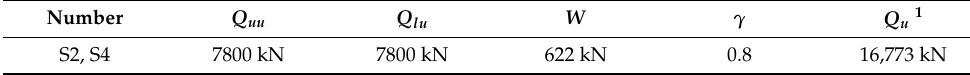
Figure 4. Equivalent transformation curves of S2 and S4. Table 3. Field test result of the compression bearing capacity Q u